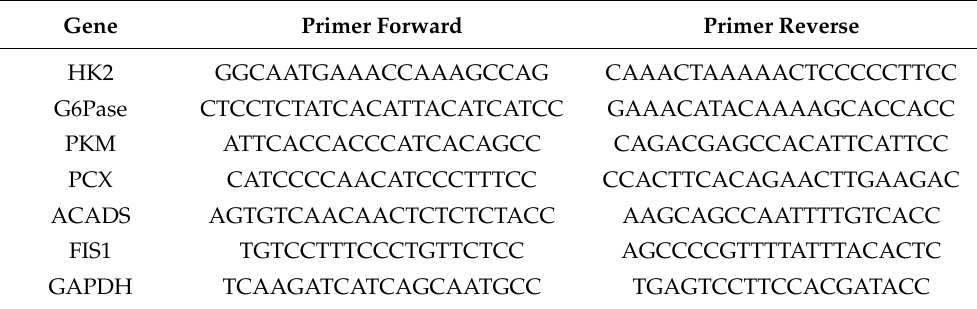
Table 1. Set of primer sequences for the one-step multiplex RT-qPCR.